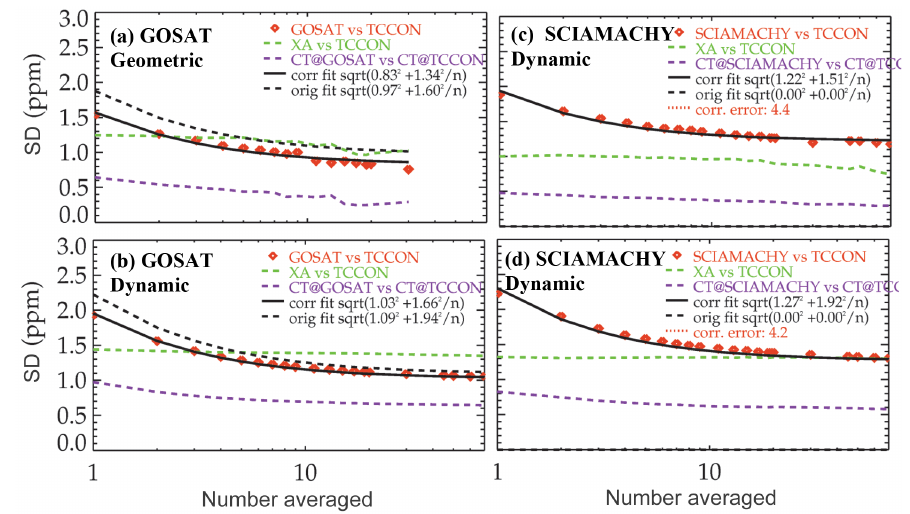
Figure 6. Averaging matches of satellite data vs. TCCON at Lamont. As the number averaged increases, the standard deviation vs. TCCON decreases. CT2013 at the satellite vs. at CT2013 at TCCON (purple) is used to quantitate spatiotemporal mismatch error. The points are fit to Eq. (2) (black). For GOSAT the uncorrected data are also fit (black dashed). The initial guess minus TCCON standard deviation is shown as a green dashed line. We see that in this case, for GOSAT at Lamont, averaging more than about four observations improves over the initial